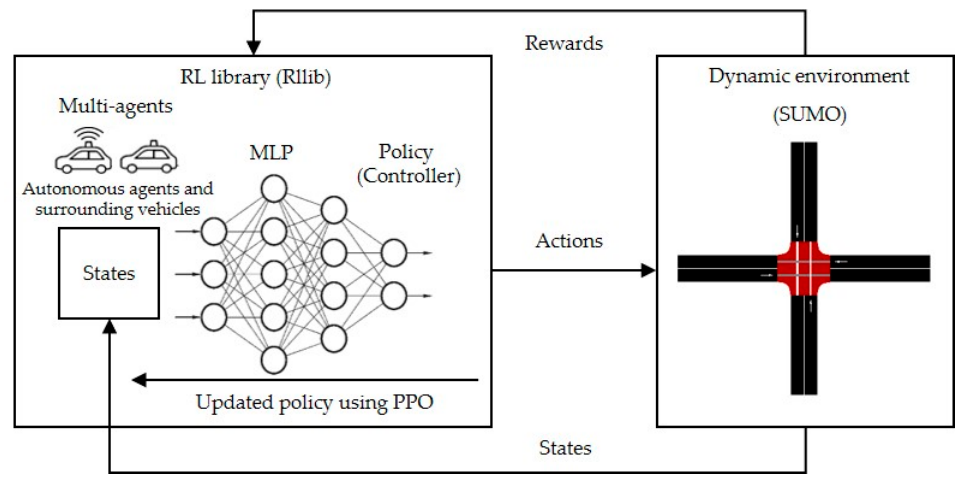
Figure 1. The deep reinforcement learning architecture in the context of a non-signalized intersection.